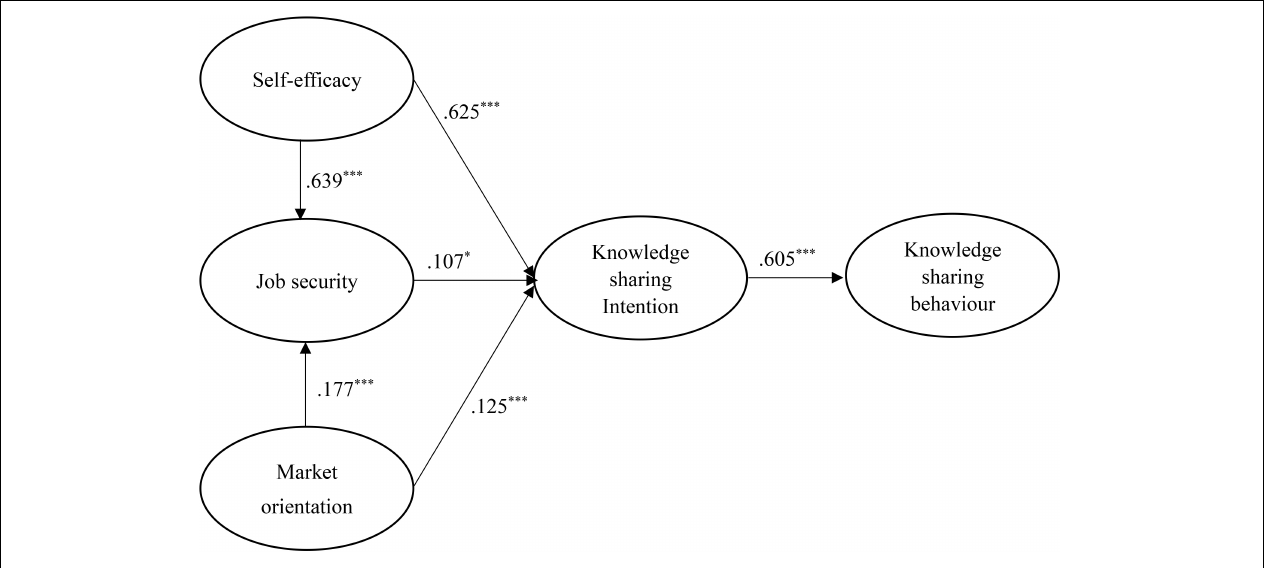
FIGURE 2 | Structural model on Mainland China employees. * p < 0.05; *** p < 0.001.